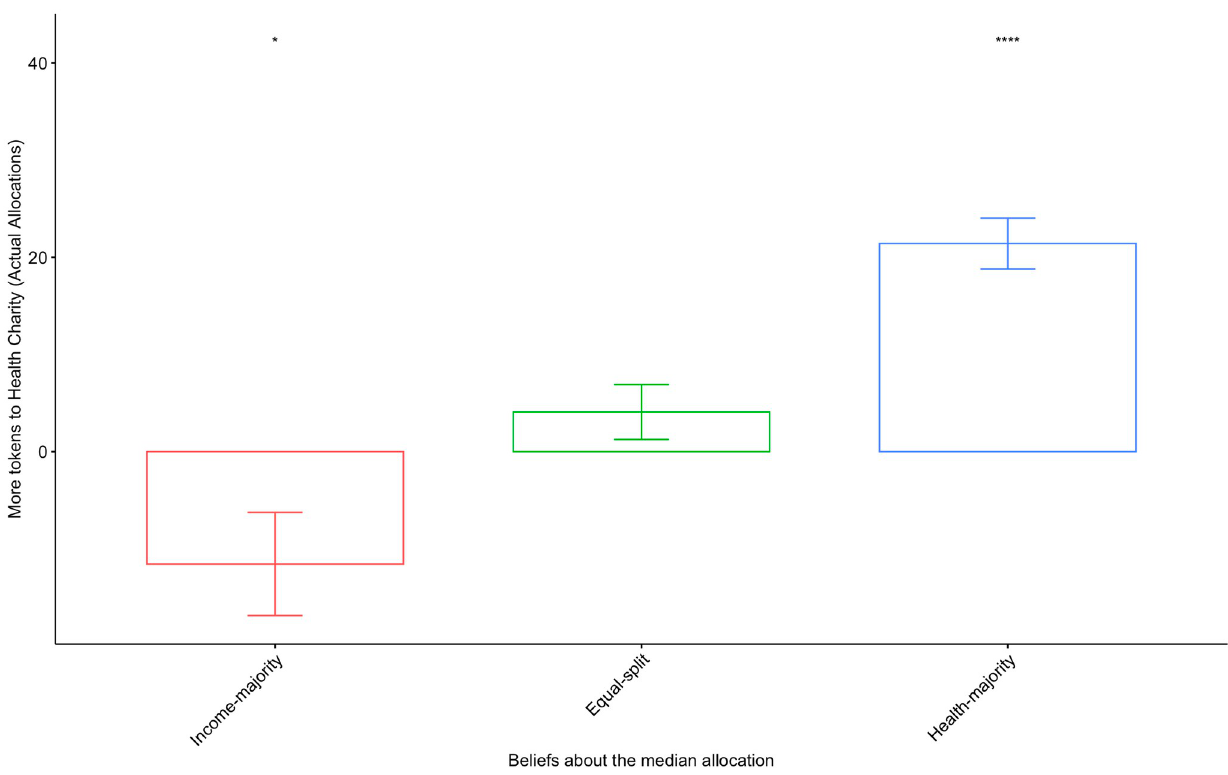
Fig 2. The relationship between beliefs and personal actions. The relationship between the average number of actual allocated token differences between the Health and Income causes and predicted allocations (positive numbers indicate relatively more allocations to the Health cause). The p-value of the ANOVA-test between observed types is less than 0.001. � p < 0.1, �� p < 0.05, ��� p <